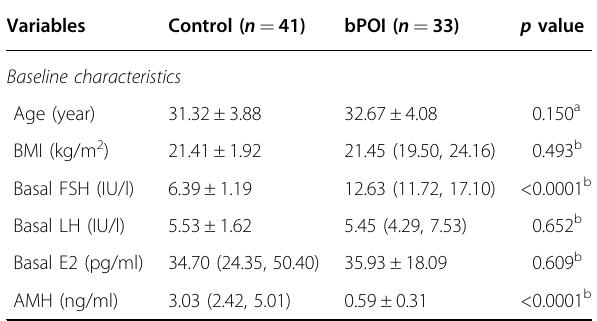
Table 1 Clinical characteristics of